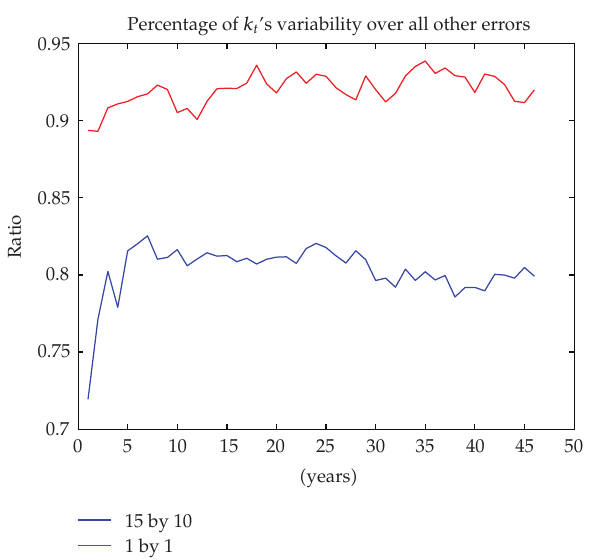
Figure 9: The ratio of k t ’s variability over all errors, 1 by 1 versus 15 by 10 (cid:2) 1921–1960 (cid:3)